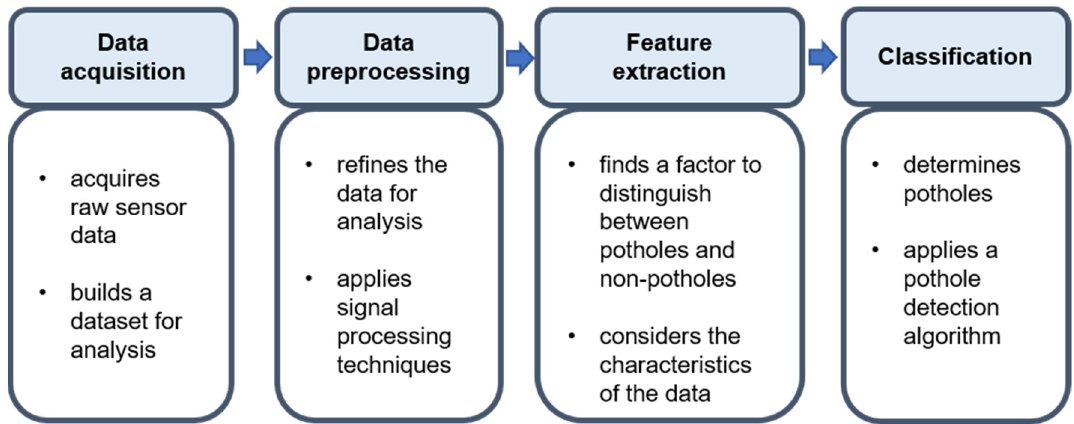
Figure 1. The general process of pothole detection.